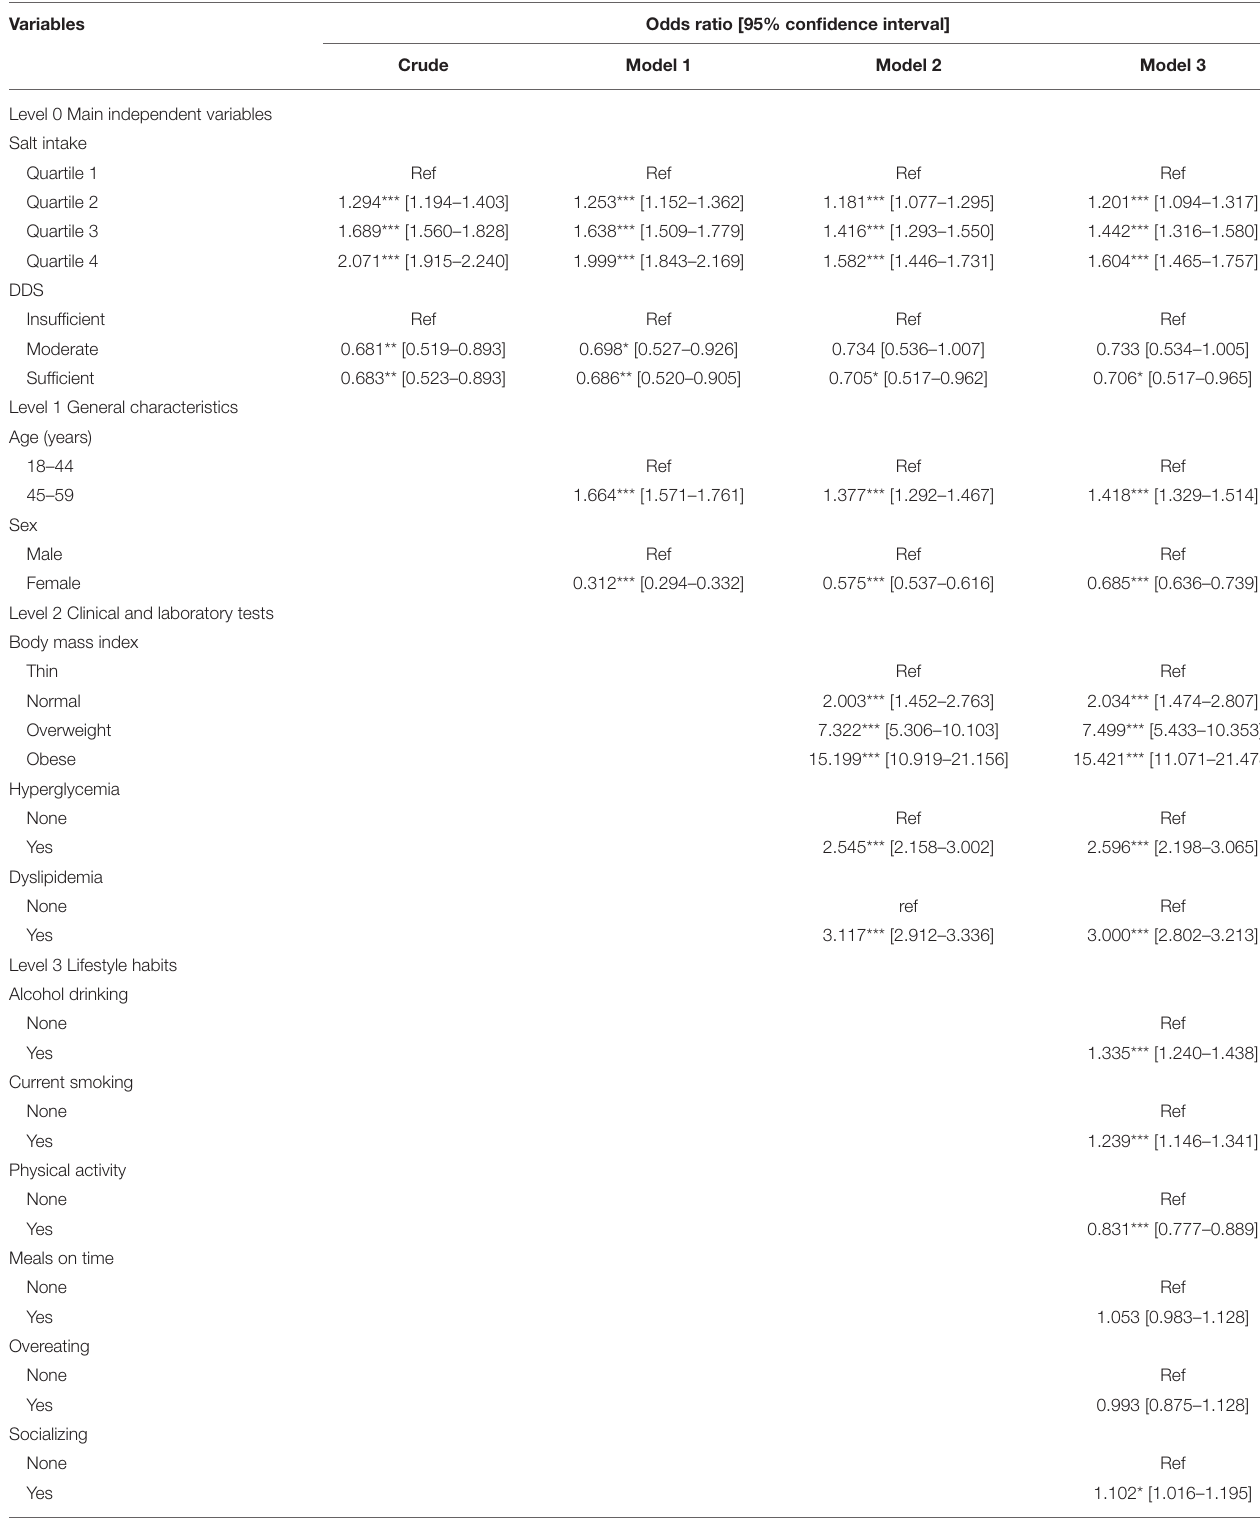
TABLE 3 | Multilevel logistic regression of NAFLD with salt intake and dietary diversity.